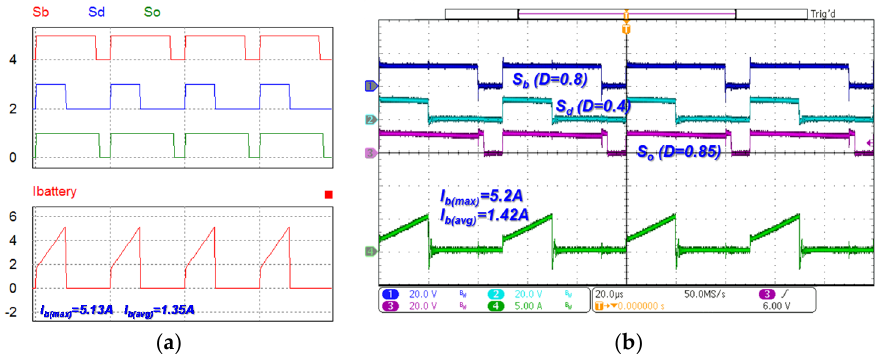
Figure 7. Gate driving signal and battery current waveforms in the battery discharging mode: ( a ) by simulation; and ( b ) by measurement. Energies 2016 , 9 , 180